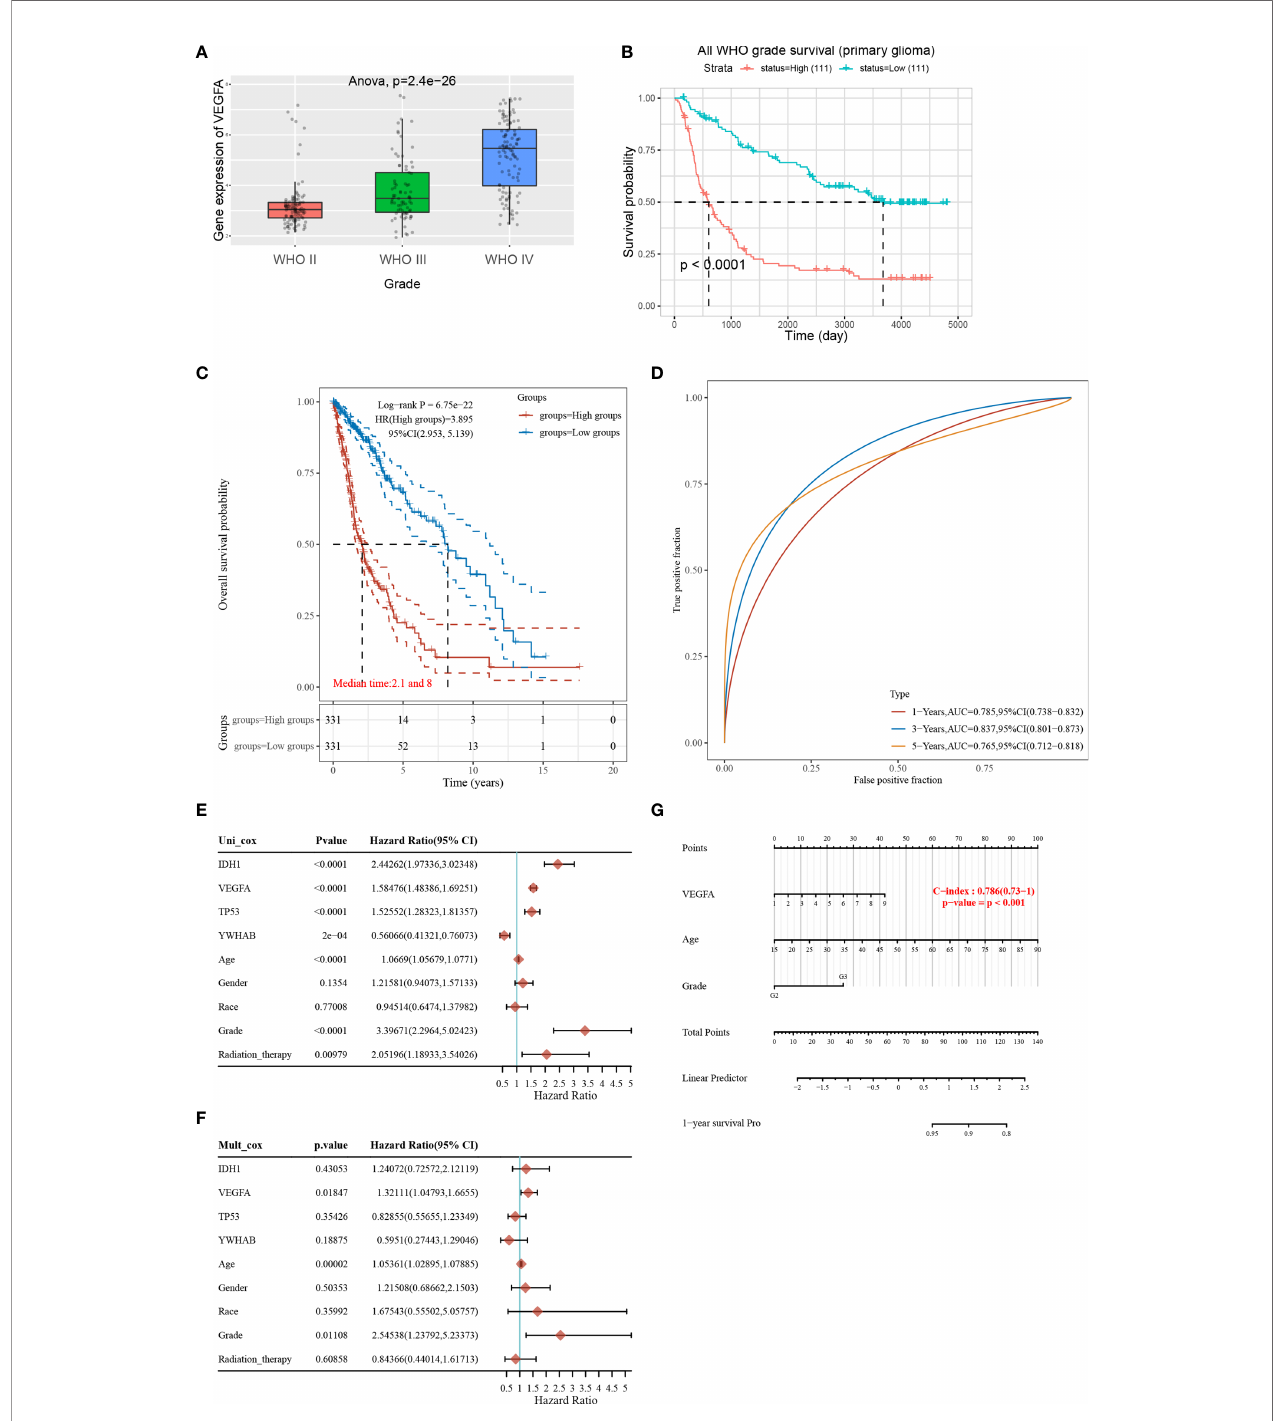
FIGURE 3 | VEGFA as a key regulator of angiogenesis is an important prognostic factor for glioma patients. (A) The expression distribution of the VEGFA gene in glioma tissues using the Chinese Glioma Genome Atlas (CGGA) data (325 glioma samples). The horizontal axis represents different groups of samples, the vertical axis represents the gene expression distribution, different colors represent different groups, and the upper left corner represents the signi fi cance p -value test method. (B) Kaplan-Meier survival analysis on VEGFA expression in the CGGA data (222 glioma samples). (C) Kaplan-Meier survival analysis of the VEGFA gene signature. (D) Time-dependent receiver operating characteristic analysis of the VEGFA gene signature for predicting 2-year, 3-year, and 5-year survival. (E, F) Hazard ratio and p ‐ value of constituents involved in univariate and multivariate Cox regression and parameters of the VEGFA gene using TCGA data (663 glioma tumors). (G) Nomogram to predict the 1-year overall survival of glioma